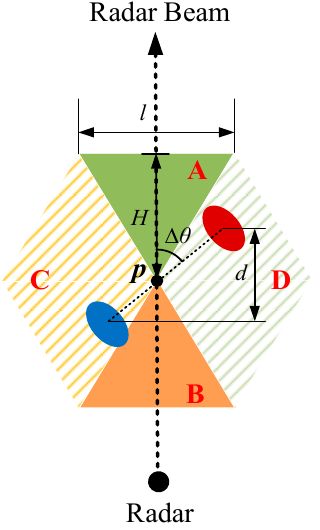
Figure 3. The regular hexagonal template for airflow field structures recognition. The blue ellipse represents the maximum inflow velocity center, and the red ellipse represents the maximum outflow velocity center. Point P is the point at the boundary line between positive and negative velocity regions. The dashed arrow represents the radar beam, d and ∆ θ are the same as in Figure 2, and H and l represent the height and base of the triangular Region A, respectively.